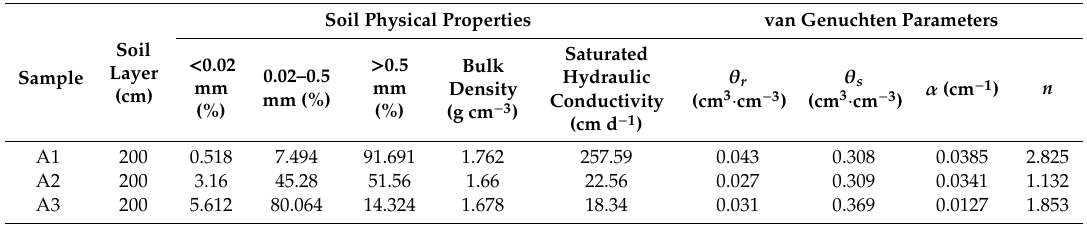
Table 1. Fundamental physical properties and parameters of van Genuchten hydraulic model.